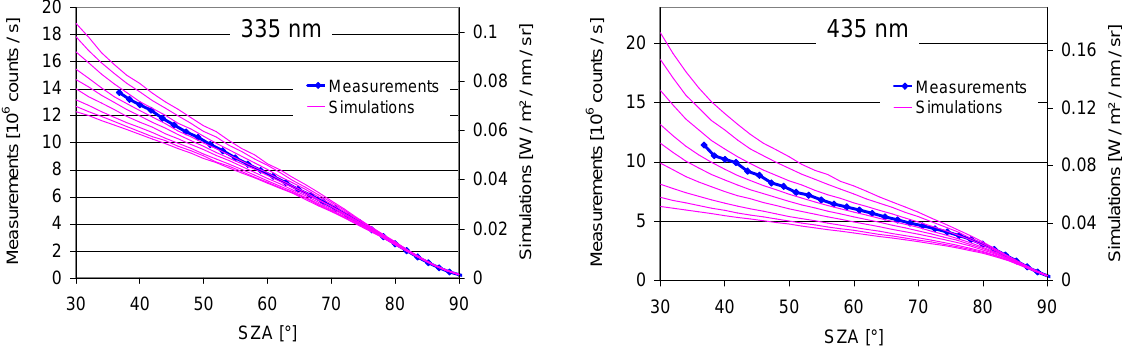
Figure 5. Comparison of measured radiances (blue, right axis) with simulated radiances (magenta lines, left axis) for two wavelengths. The lowest simulated radiances are obtained for AOD = 0, and the highest radiances for AOD = 0 . 5. Results for additional wavelengths are shown in Fig. A3.